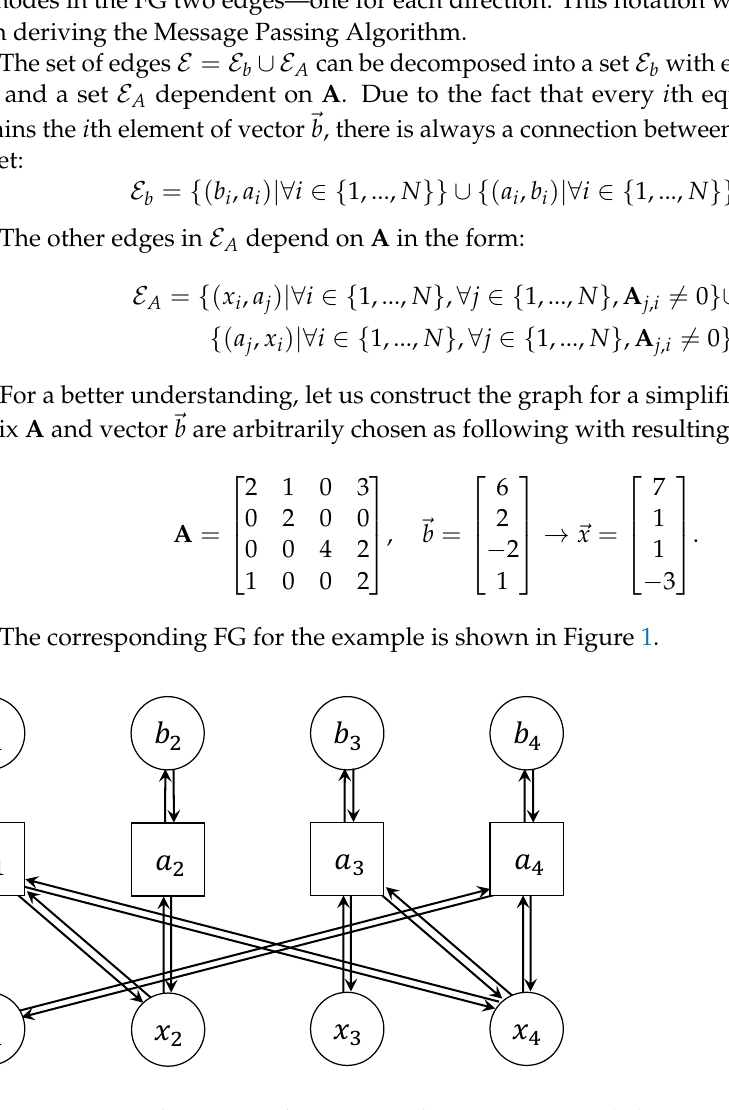
Figure 1. Factor Graph corresponding to example LES in Equation